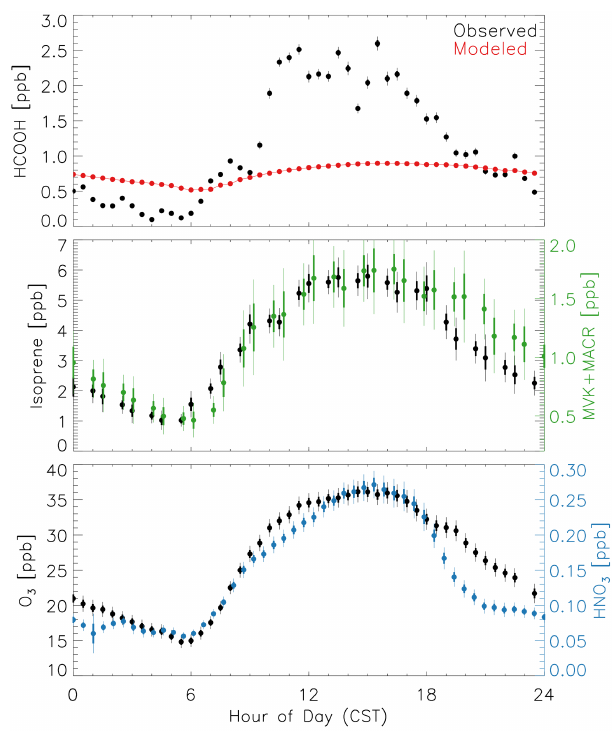
Figure 7. Diurnal cycle of HCOOH and related species as measured during SOAS. Error bars indicate ± 1 (thick) and ± 2 (thin) standard errors about the observed mean